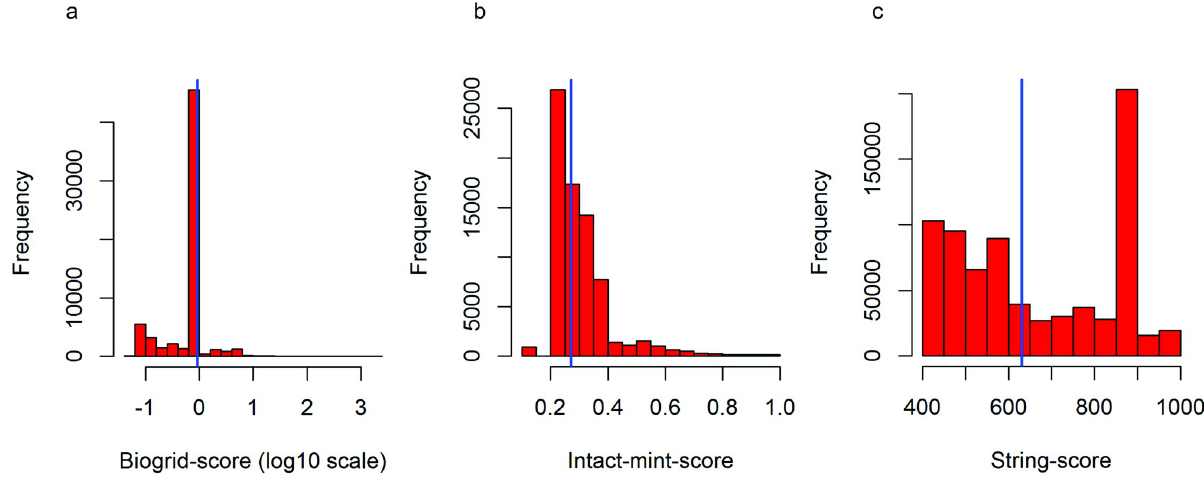
Fig 1. Confidence score distributions of PPI in (a) Biogrid, (b) Intact and Mint, and (c) String. The blue vertical line in all of them corresponds to the median of the distributions. The interactions which have a confidence score above the median were considered for the current study.